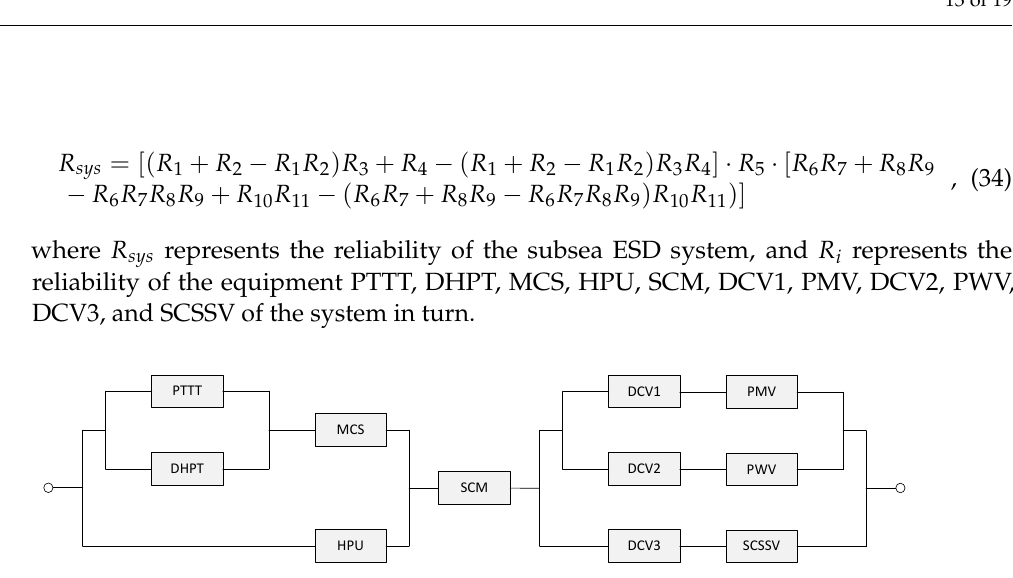
Figure 8. Reliability block diagram of subsea emergency shutdown